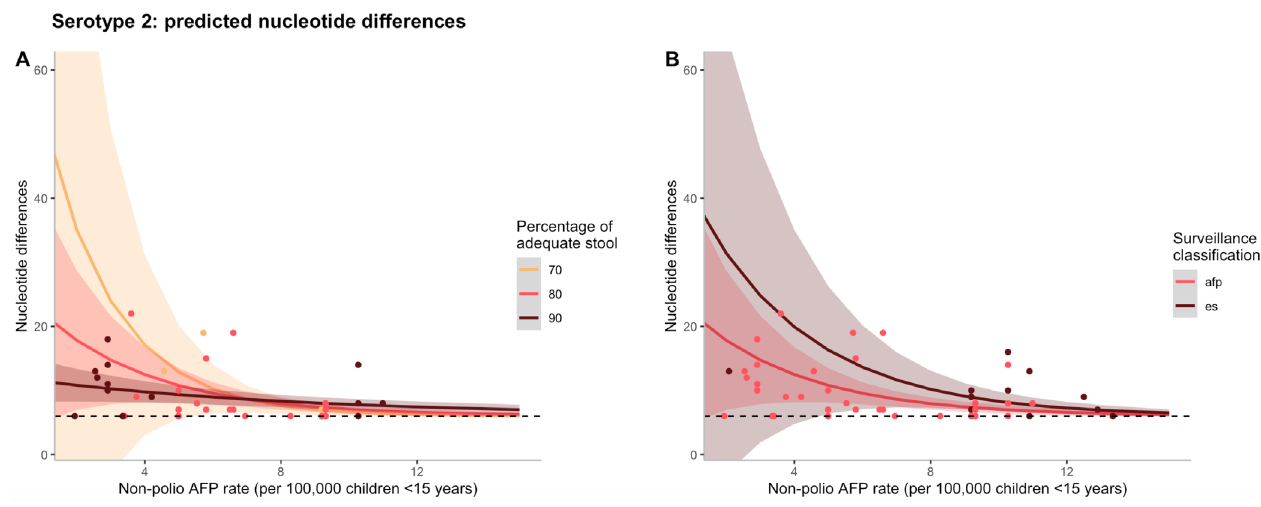
Figure 1. ( A ) Predicted counts of nucleotide differences for serotype 2 based on the final negative binomial regression model vs. non-polio AFP rate (per 100,00 children <15 years of age). The different colour lines correspond to varying percentages of adequate stool samples collected and the shaded regions represent a 95% confidence interval of model predictions. The different colour points also correspond to varying percentages of adequate stool samples collected, but represent data from a particular cVDPV2 outbreak. ( B ) Predicted counts of nucleotide differences for serotype 2 based on the final negative binomial regression model vs. non-polio AFP rate (per 100,00 children <15 years of age). The different colour lines correspond to the type of surveillance via which the first isolate was detected and the shaded regions represent a 95% confidence interval of model predictions. The different colour points also correspond to the type of surveillance via which the first isolate was detected, but represent data from a particular cVDPV2 outbreak. In both figures, the black dashed line represents the minimum threshold cut-off of nucleotide differences (n=6) to be considered a cVDPV2.